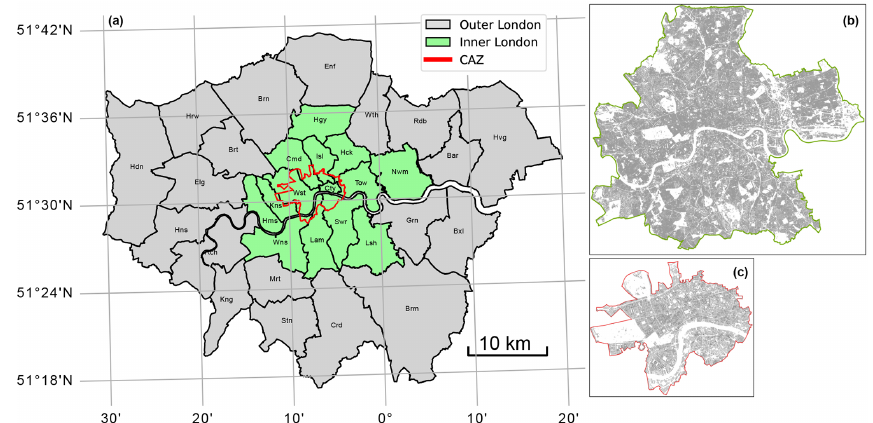
Figure 1. (a) Local authority districts in Greater London, identified by the first three consonants of their names. Inner London is shaded green, Outer London is in grey, and the outline of the CAZ is shown in red. Zoomed-in maps of (b) Inner London and (c) the CAZ. Table 2. Input geospatial dataset